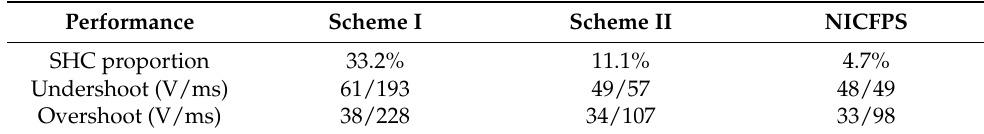
Table 3. Experimental results comparison.